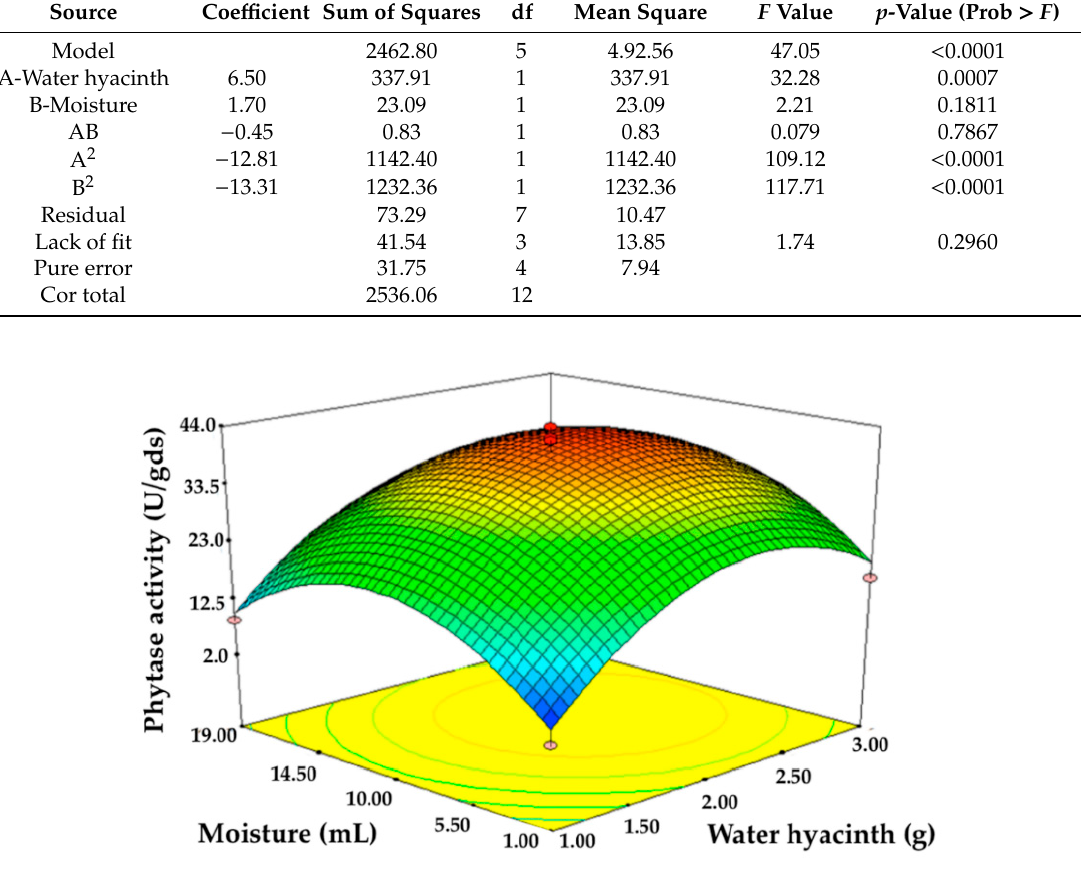
Figure 4. Contour surface plot showing the optimum region and interactions between water hyacinth and moisture content for the phytase production from P. adiposa .